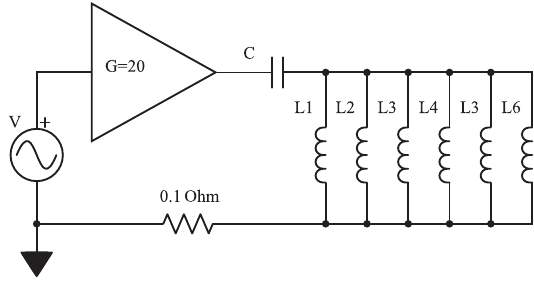
Fig. 3 Electromagnet core and windings.